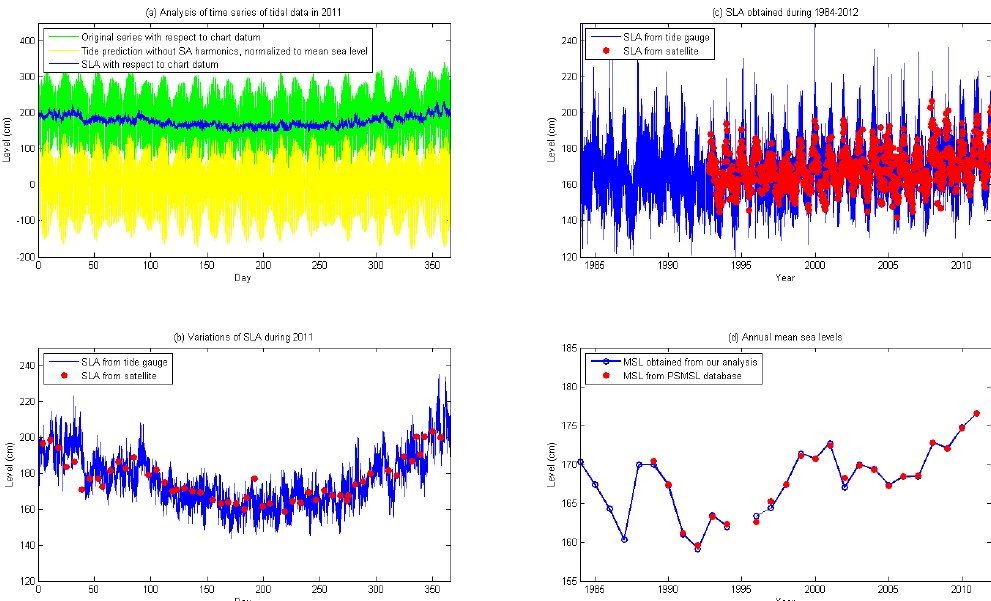
Fig. 2. Analysis of Tanjong Pagar tide station data: (a) Typical annual tide gauge record and derived sea level anomalies; Comparison of sea level anomalies derived from the tide gauge and satellite altimetry (AVISO) for (b) a typical year, and (c) the period 1984–2012; (d) Annual sea levels obtained in our analysis (blue lines) in accordance with these achieved in PSMSL database (red symbols).